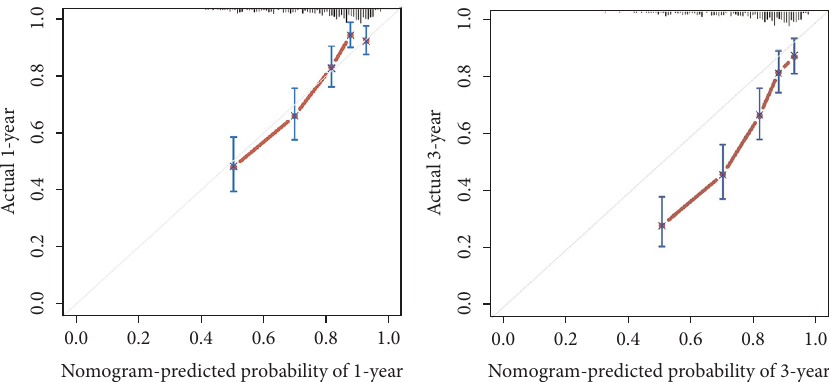
Figure 5: The calibration curves in the external validation